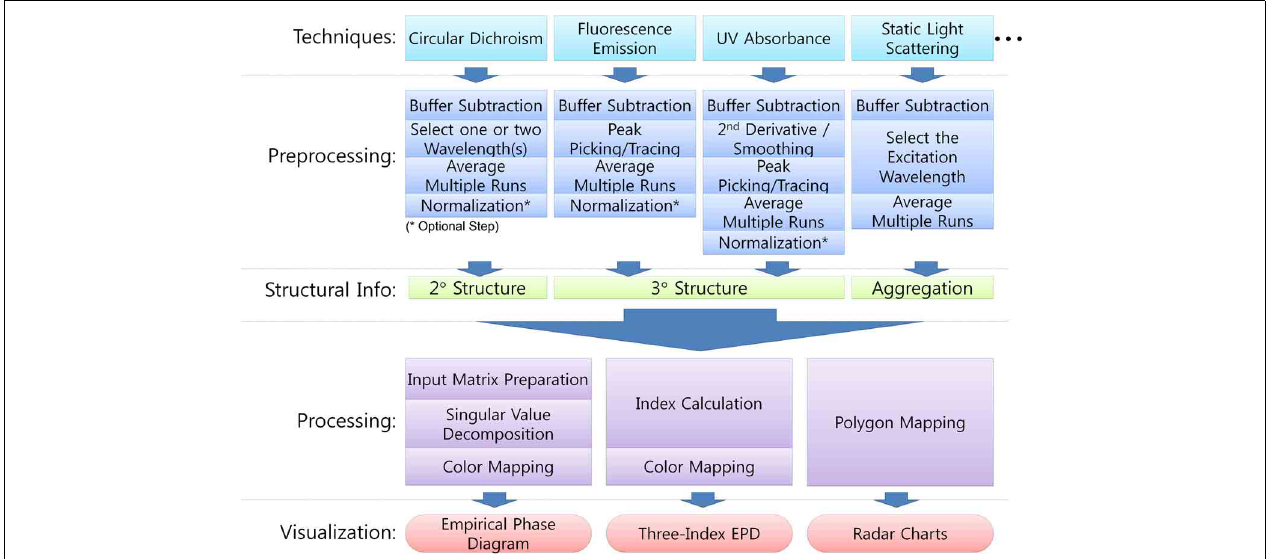
FIGURE 2 | Typical procedure for collection of biophysical stability data sets and construction of Empirical Phase Diagram (EPDs), Three-Index EPDs, and radar charts for data visualization and analysis.